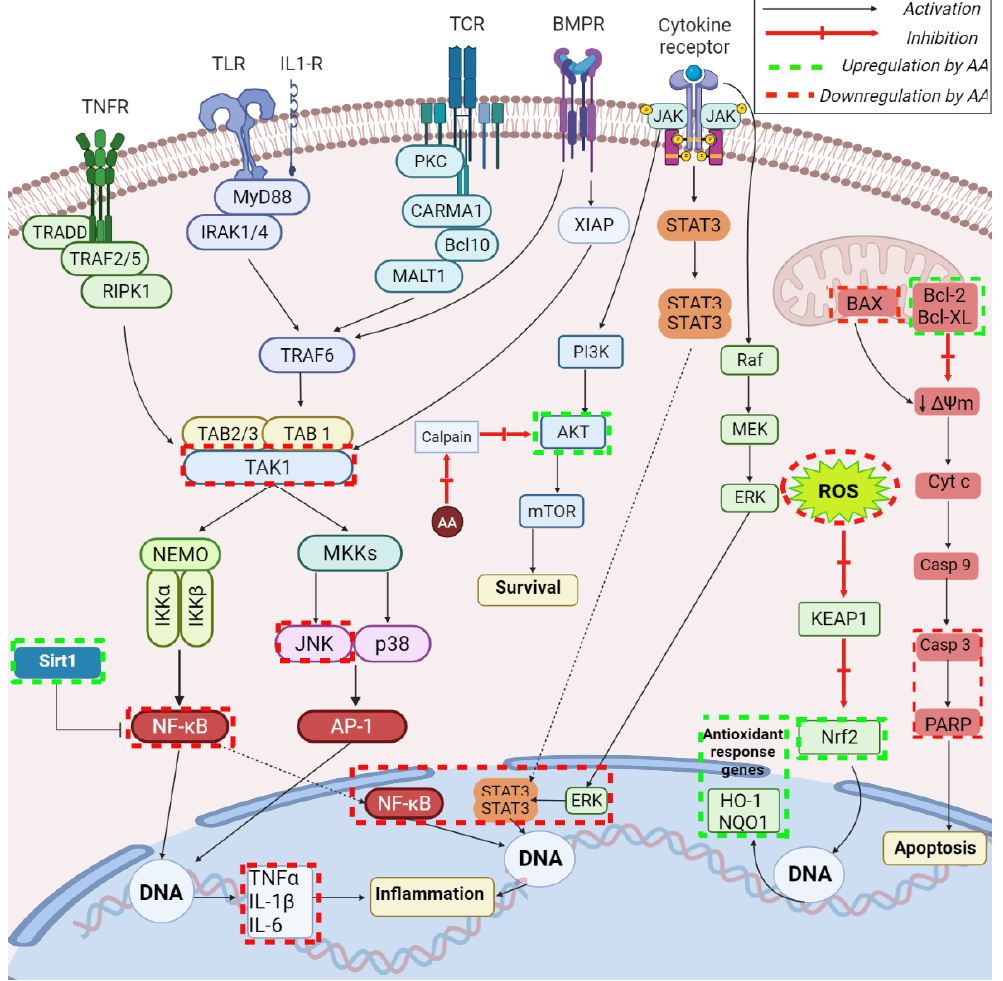
Figure 6. Schematic representation of the reported neuroprotective mechanisms of AA; key signaling pathways targeted by AA in neurodegeneration: inhibition of NF-kB/STAT3/ERK signaling pathway-> down-regulation of TNF- α , IL-1 β and IL-6; up-regulation of Bcl and down-regulation of Bax -> anti- inflammatory and antiapoptotic effect; inhibition of TAK1-JNK pathway -> anti-inflammatory effect; up- regulation of Nrf2/HO-1 pathway -> reduction of ROS -> antioxidant effect. Created with BioRender.com (accessed on 8 May